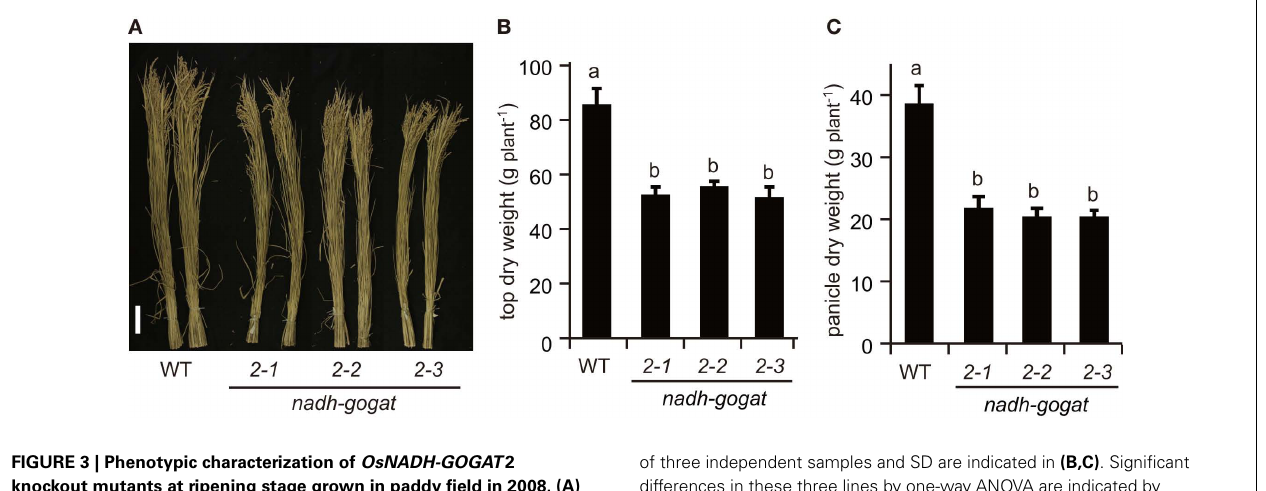
FIGURE 3 | Phenotypic characterization of OsNADH-GOGAT 2 knockout mutants at ripening stage grown in paddy field in 2008. (A) Phenotype at harvest. Names of three mutant lines were the same as described in Figure 2 . Scale bar is 10cm. (B) Total dry weight of top part (above ground) per plant. (C) Total dry weight of panicles per plant. Means